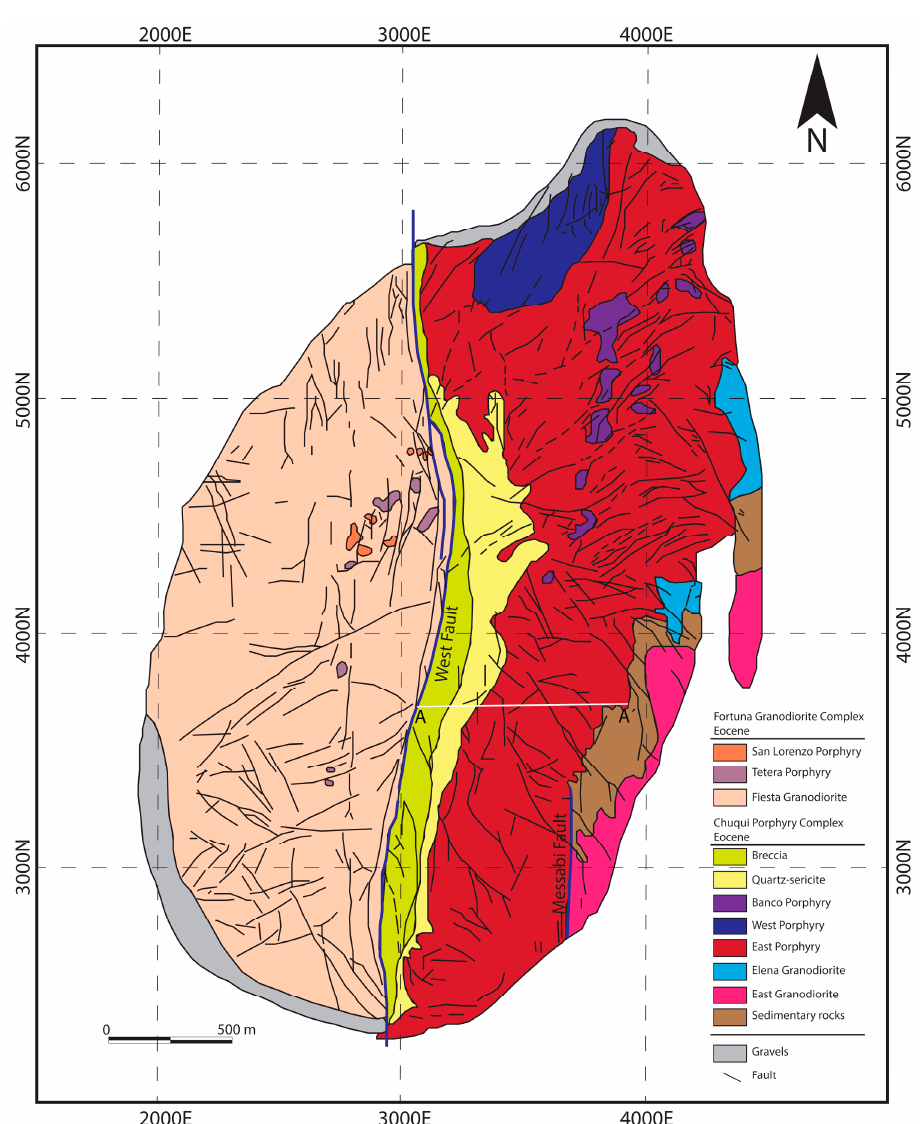
Figure 2. Geology of the Chuquicamata porphyry Cu-Mo deposit. Modified from Ossand ó n et al., 2001 [47]. Datum: WGS84 Huso